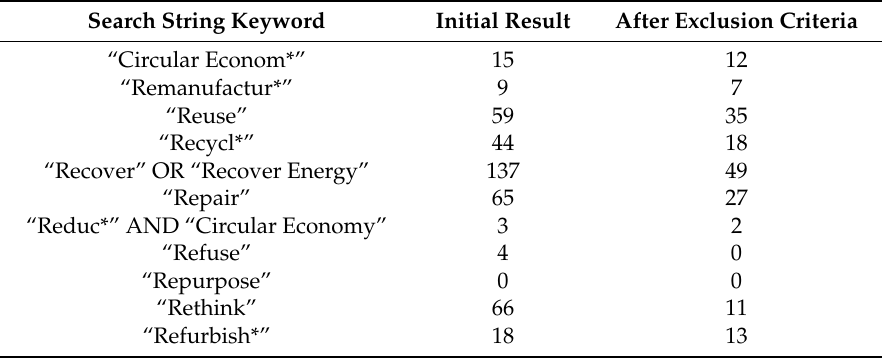
Figure 5. The 9R Framework of Circular Approaches with the production chain in order of priority. Source: Adapted from Potting et al., (2017, p. 5) [64]. Table 4. Paper selection with search